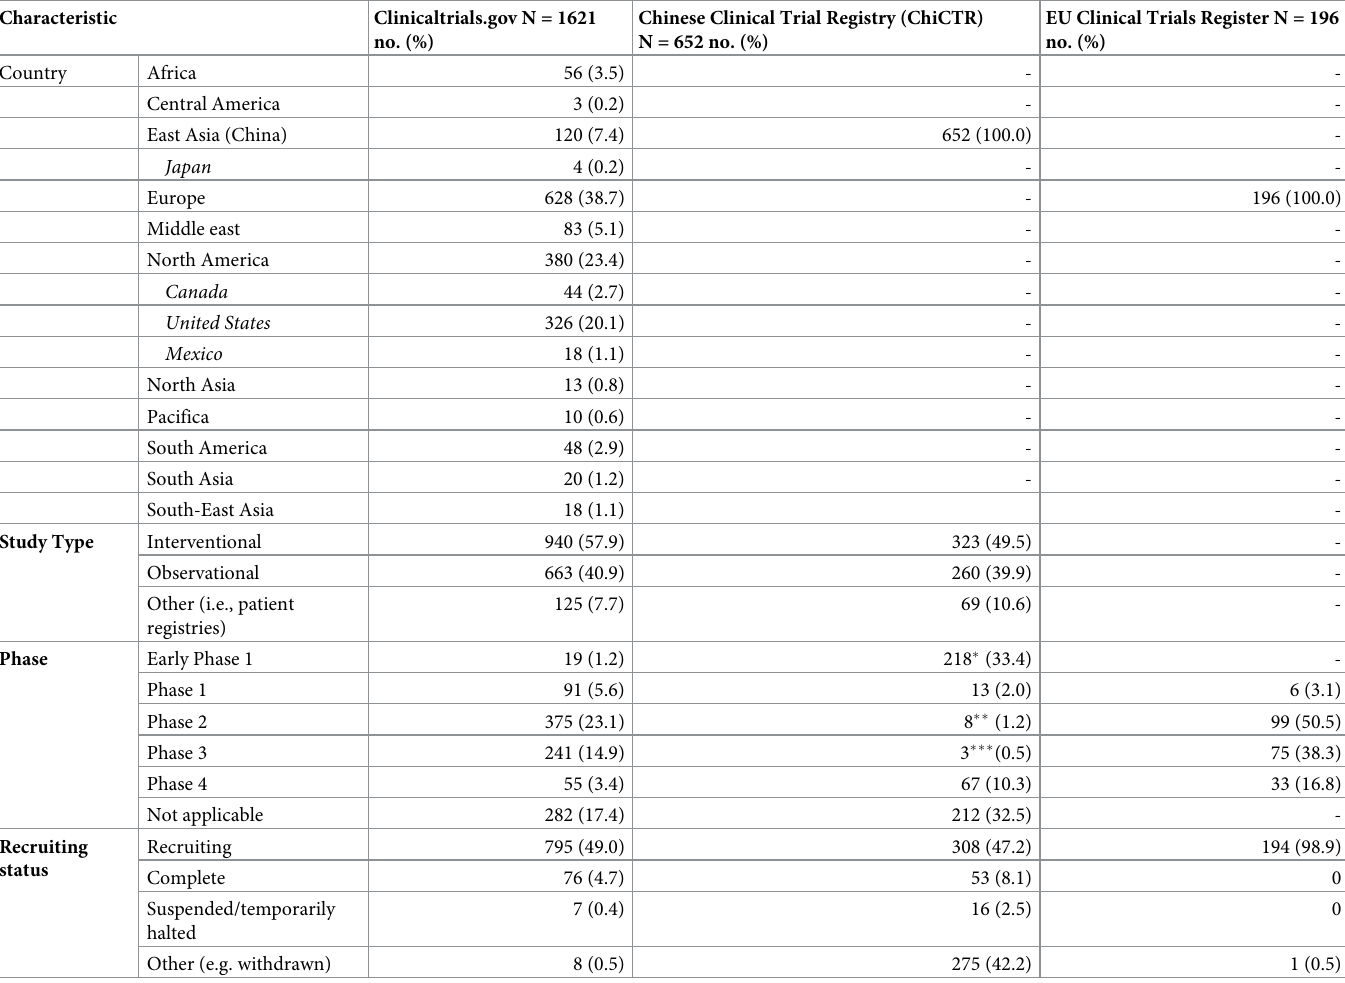
Table 3. Characteristics of primary registries with highest number of COVID-19-related trials. (absolute frequencies).